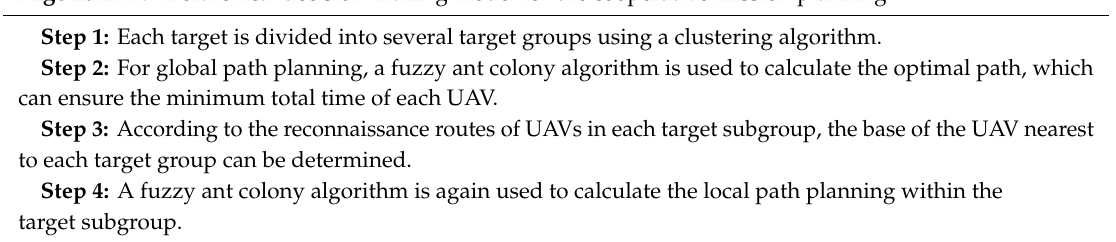
Algorithm 1: Hierarchical decision-making model for the cooperative mission